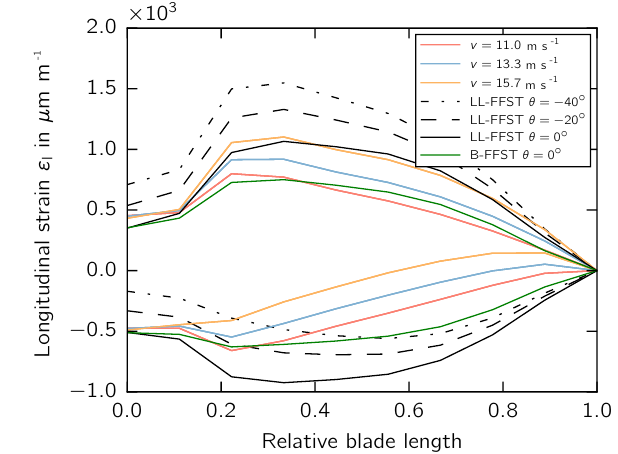
Figure 8. Stress ratio R of the axial strain along the trailing-edge bond line at different wind speed bins, and lead–lag (LL-FFST) and bi-axial (B-FFST) fatigue full-scale blade tests at different pitch an-